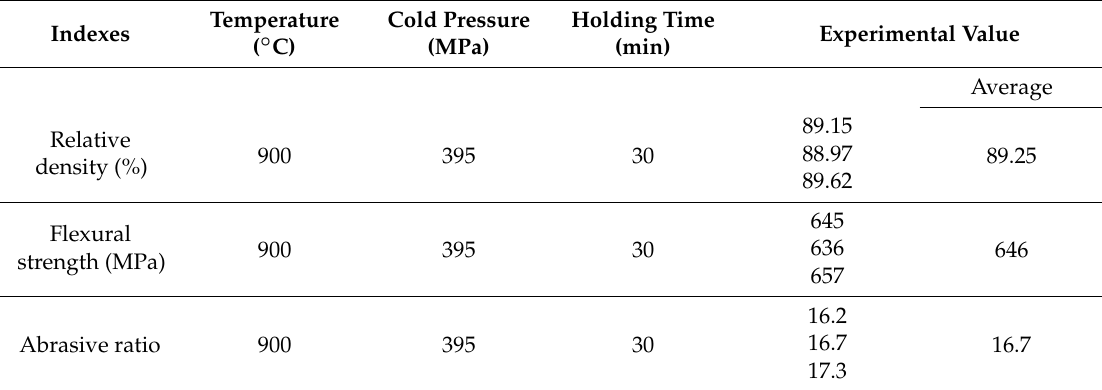
Table 8. Experimental results of conventional